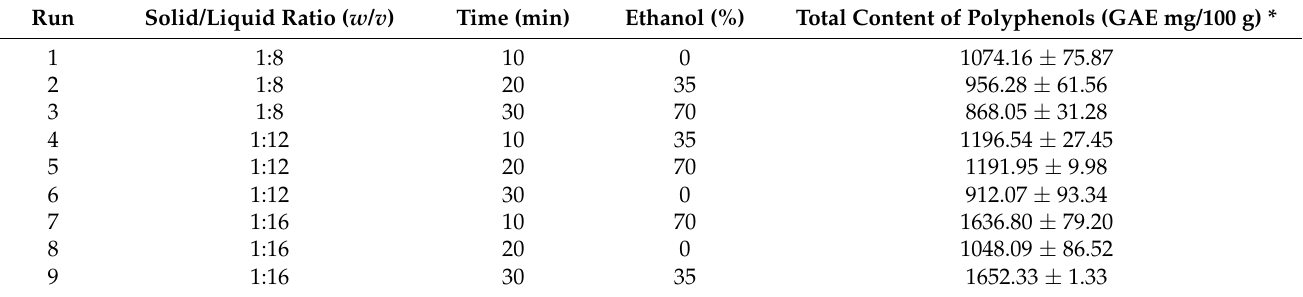
Table 1. Experimental matrix for the orthogonal array L9 (3 3 ) and total content of polyphenols for the experimental